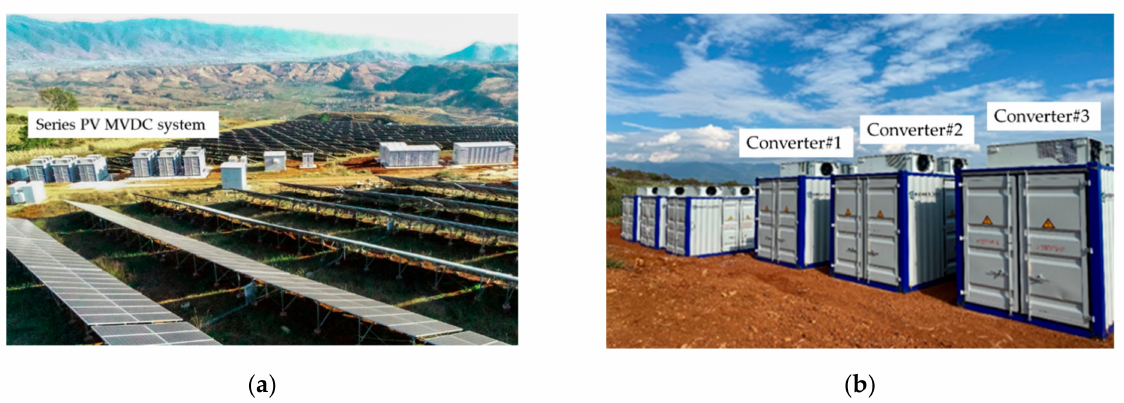
Figure 16. Series PV system and MVDC converter. ( a ) Series PV system; ( b ) PV MVDC